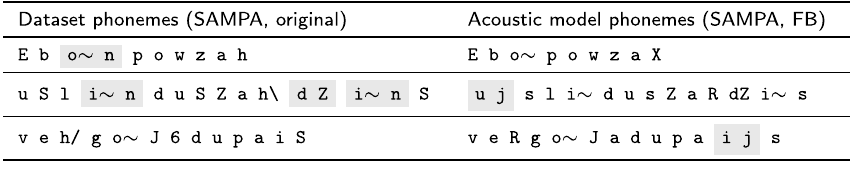
Table 7 Example of a single news file with phonemes from three out of 385 TextGrid files for